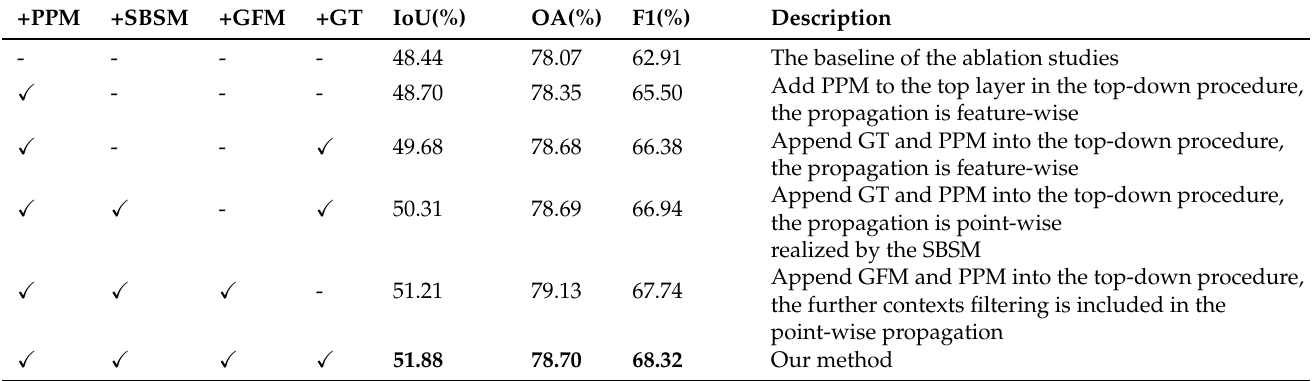
Table 5. Ablation experimental results. The bold values in each column means the best entries.